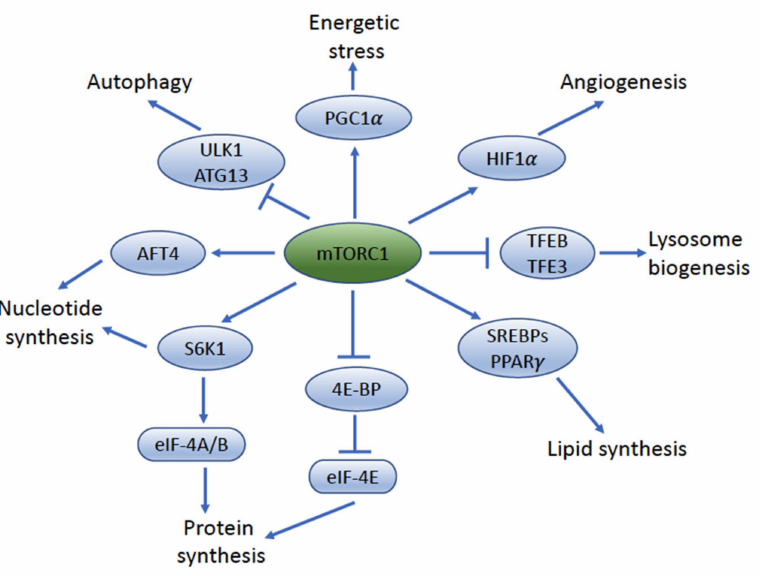
Figure 3. The key downstream target molecules and function pathways of mTORC1 . mTORC1 is a master regulator of cellular anabolism and promotes cell metabolism, growth, and proliferation by regulating a variety of downstream effectors, including mRNA translation; biosynthesis of proteins, nucleotides, and lipids; autophagy; lysosomal biogenesis; and angiogenesis. 4E-BP, 4E-binding protein; eIF-4E, eukaryotic translation initiation factor 4E; S6K1, p70 S6 kinase 1; eIF-A/B, eukary- otic translation initiation factor 4A/B; HIF1 α , hypoxia-inducible factor 1 α ; PGC1 α , peroxisome proliferator-activated receptor γ coactivator 1- α ; SREBP, sterol regulatory element-binding protein; PPAR γ peroxisome proliferator-activated receptor- γ ; TFEB, transcription factor EB; TFE3, transcrip- tion factor E3; ULK1, unc-51-like autophagy- activating kinase 1; ATG13, autophagy-related 13; AFT4, activating transcription factor